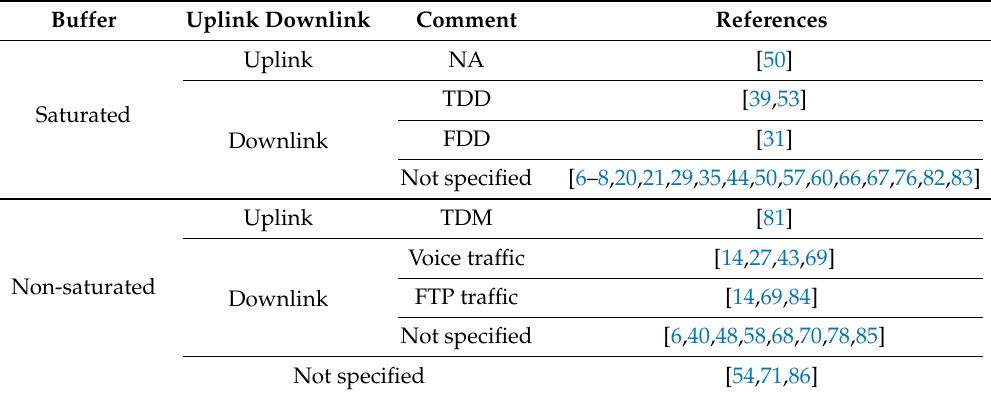
Table 2. A summary of traffic models studied for